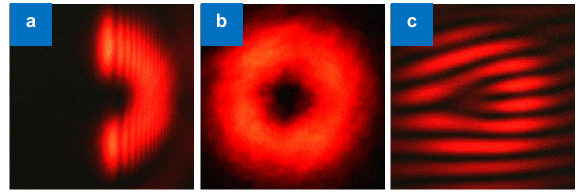
Fig. 6 | Experimental results for LG 02 beam. ( a ) The intensity distribution of the LG 02 beam incident on the FP cavity with unblocking percentages of 50%. ( b ) The intensity distribution of the transmitted light from the FP cavity with the resonant cavity length of the LG 02 beam. ( c ) The interference pattern between the transmitted light and the reference Gaussian